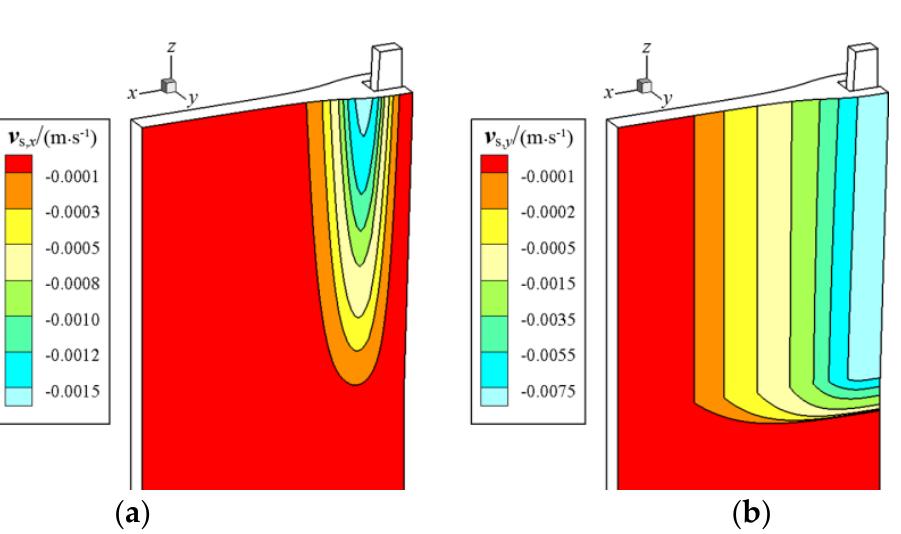
Figure 6. Schematic distribution of shell surface velocity on the funnel region of the CSP mold: ( a ) X -velocity and ( b ) Y